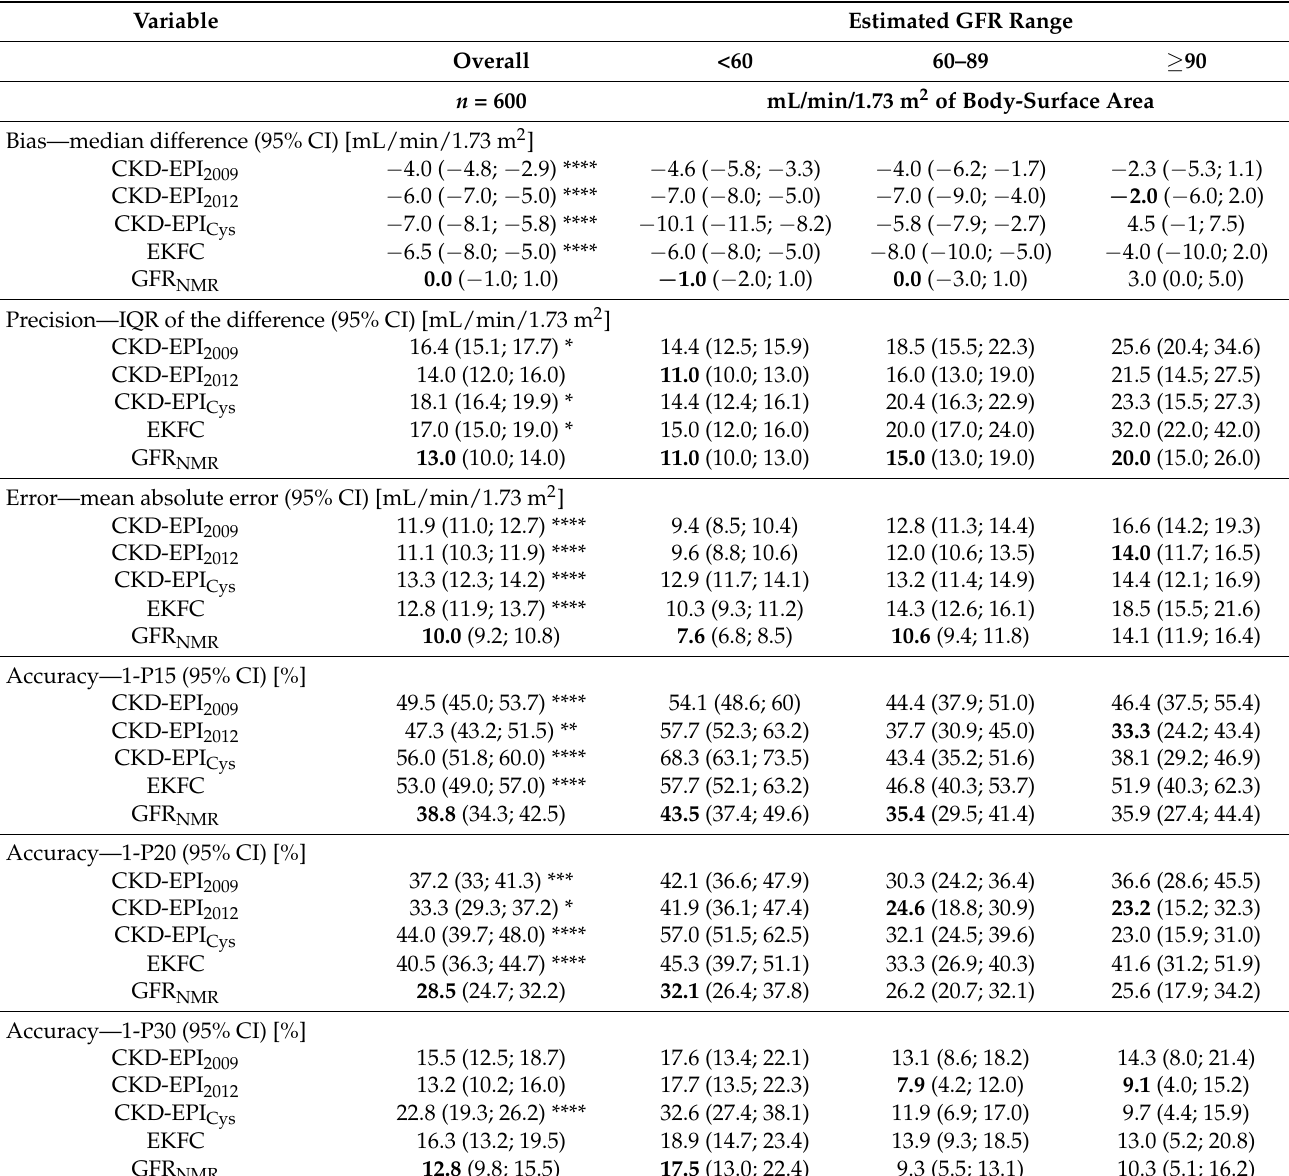
Table 3. Performance of eGFR-estimating equations in the overall external validation set ( n = 600) and according to eGFR